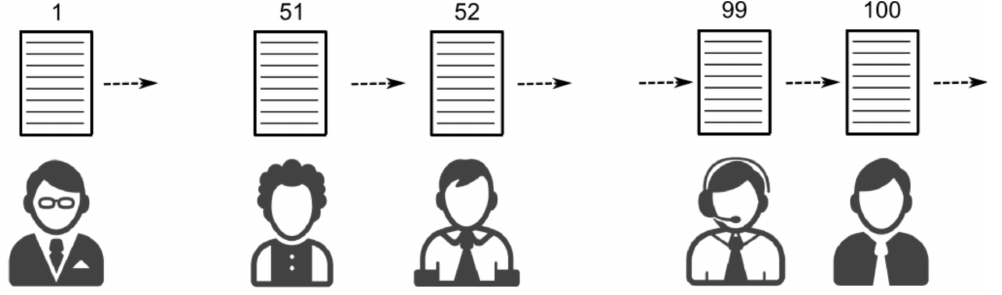
Fig. 2. Different Cases of Validation of